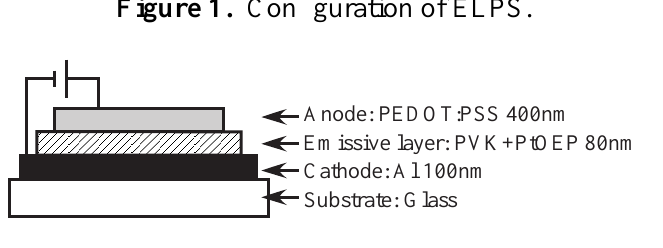
Figure 1. Configuration of